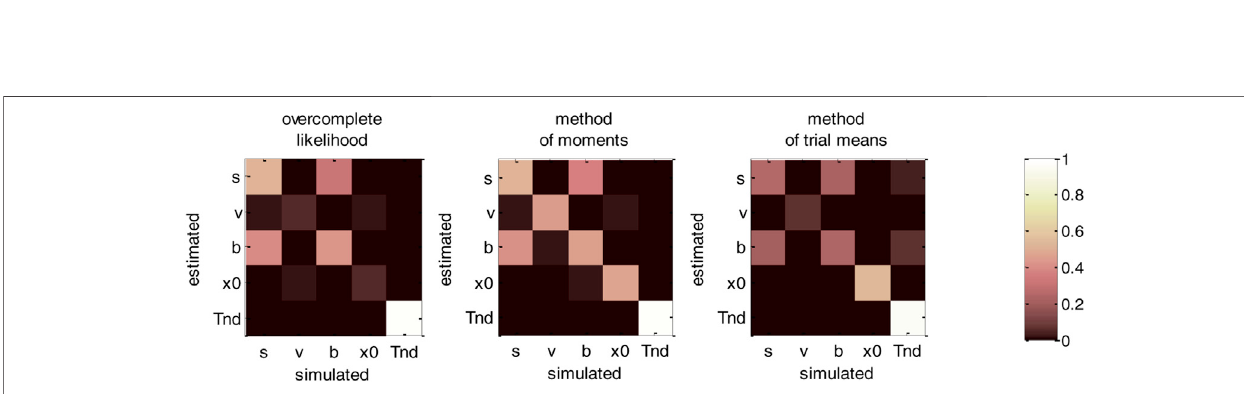
FIGURE8| DDM parameter recoverymatrices (fullparameter set). Leftpanel: overcompleteapproach. Middle panel: method ofmoments.Right panel: Method of trial means. Each line shows the squared partial correlation coef fi cient between a given estimated parameter and each simulated parameter (across 1000 Monte-Carlo simulations). Note that perfect recovery would exhibit a diagonal structure, where variations in each estimated parameter is only due to variations in the corresponding simulated parameter. Diagonal elements of the recovery matrix measure “ correct estimation variability ” , i.e., variations in the estimated parameters that are due to variationsinthecorrespondingsimulatedparameter.Incontrast,non-diagonalelementsoftherecoverymatrixmeasure “ incorrectestimationvariability ” ,i.e.,variationsin theestimatedparametersthatareduetovariationsinotherparameters.Strongnon-diagonalelementsinrecoverymatricesthussignalpairwisenon-identi fi abilityissues.